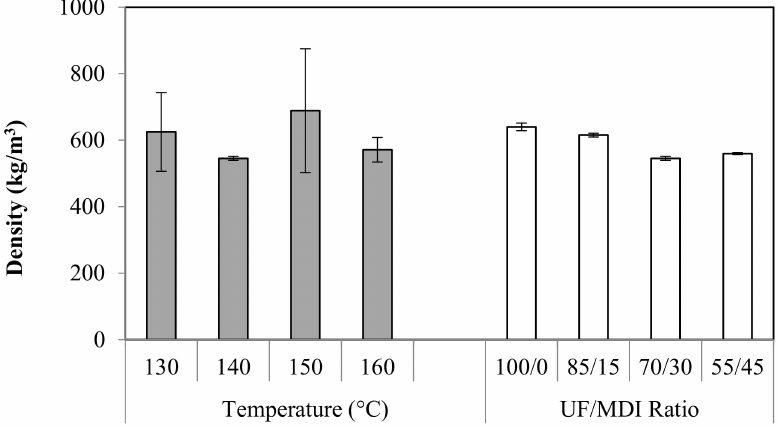
Figure 3. The density of the particleboard. The bars indicate the standard